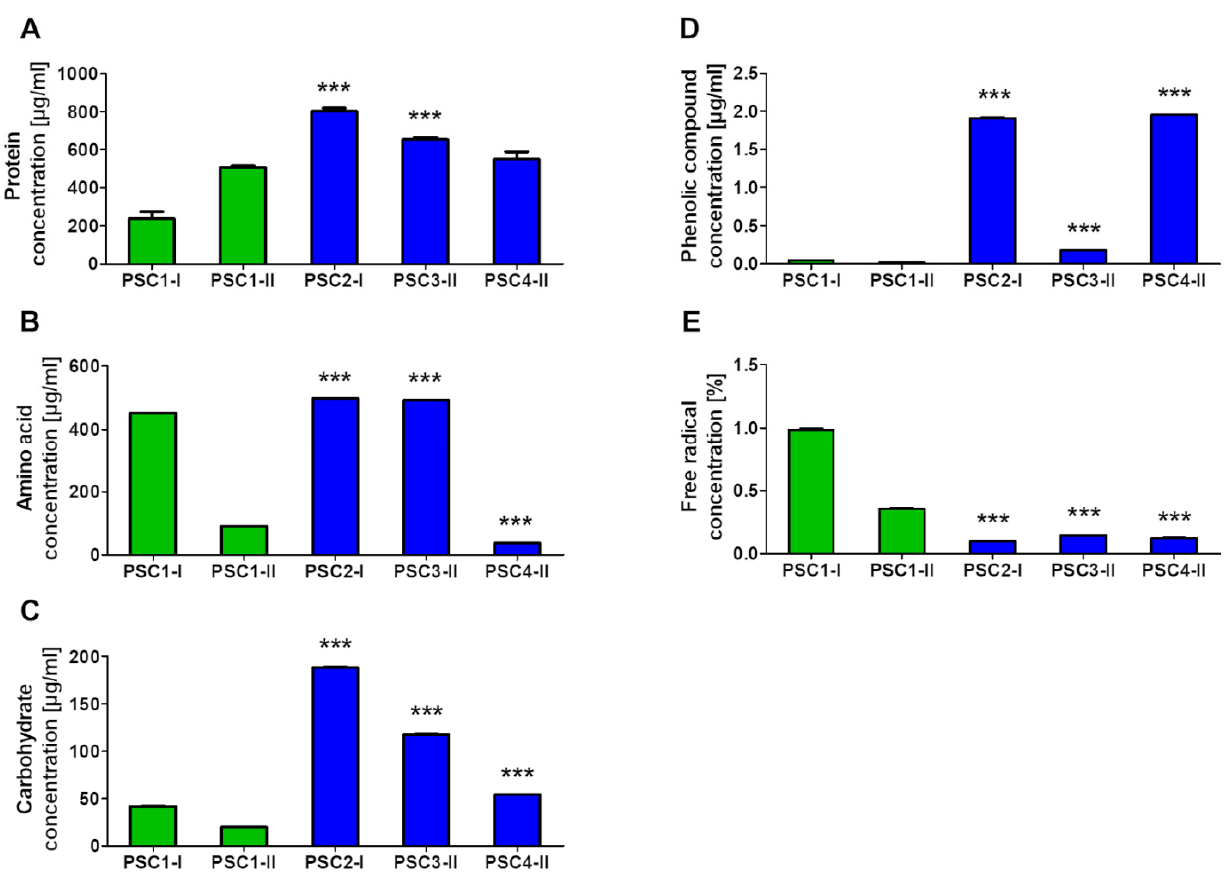
Figure 1. Biochemical composition of the PSC2-I, PSC3-II, and PSC4-II extracts compared to the control (PSC1-I for PSC2-I, and PSC1-II for PSC3-II and PSC4-II): concentration of proteins ( A ), amino acids ( B ), carbohydrates ( C ), phenolic compounds ( D ), level of free radicals ( E ); *** p < 0,005, one-way ANOVA, Dunnett’s test.